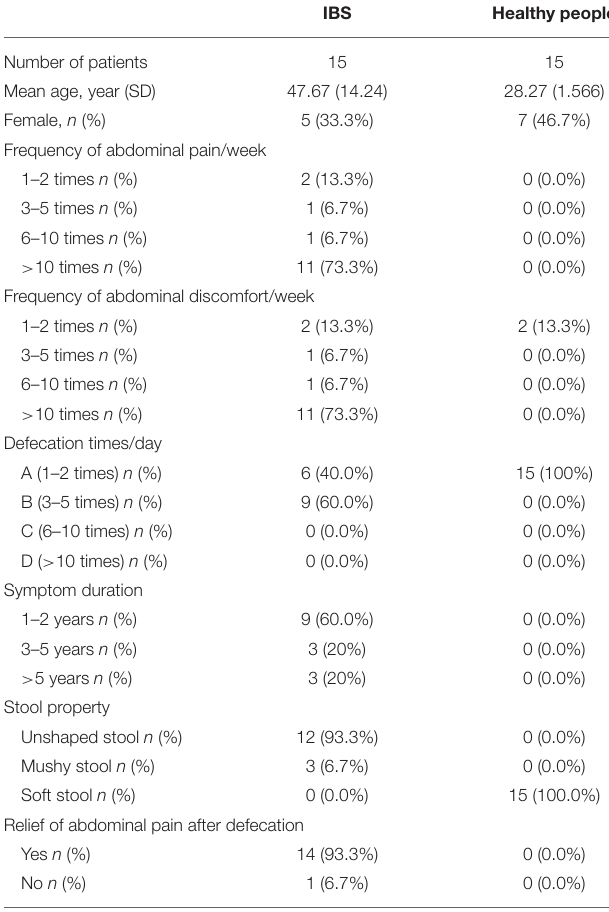
TABLE 1 | Demographic and clinical information of participants of this